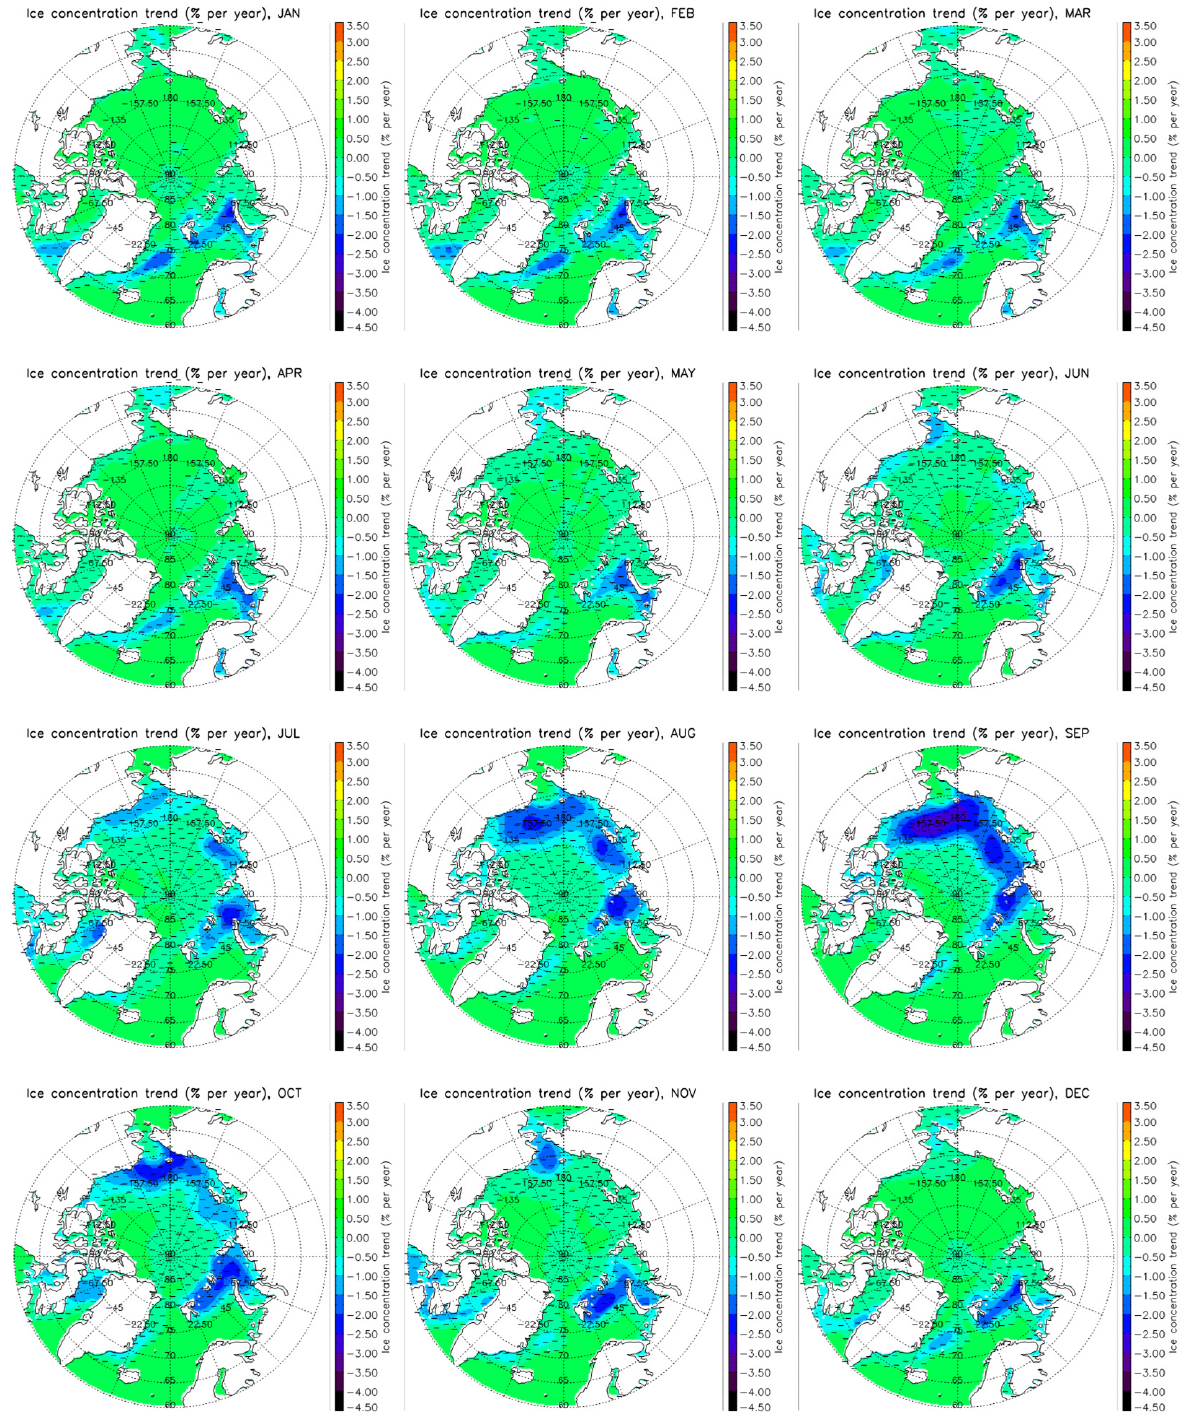
Figure 6. Spatial distributions of Arctic monthly mean SIC trends for the months of January through December over 1982–2020. The SIC decreasing areas are marked with minus signs.